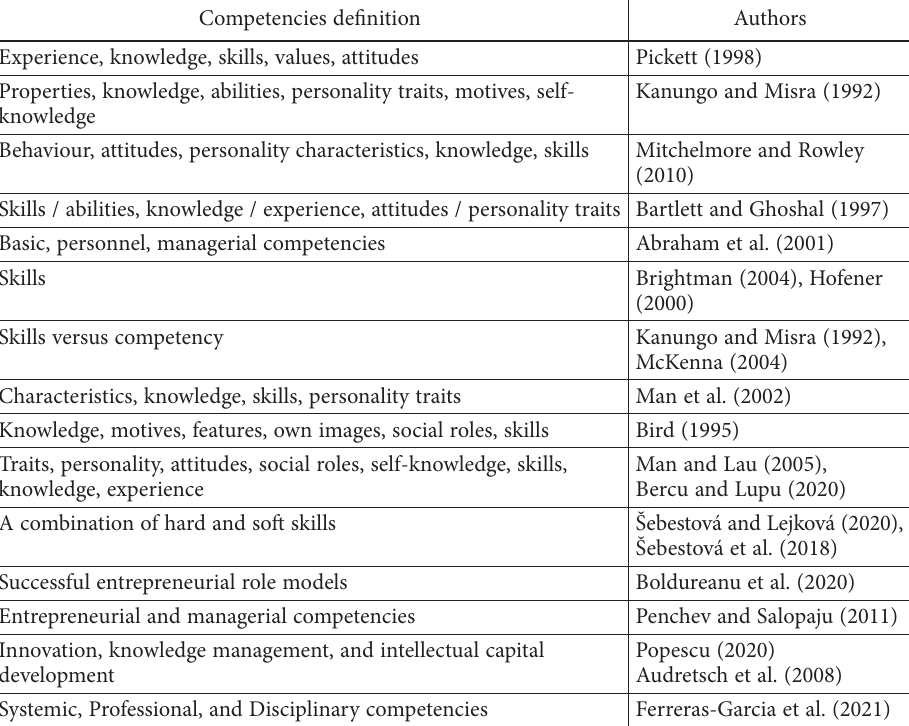
Table 1. A summary of competency definitions (source: authors